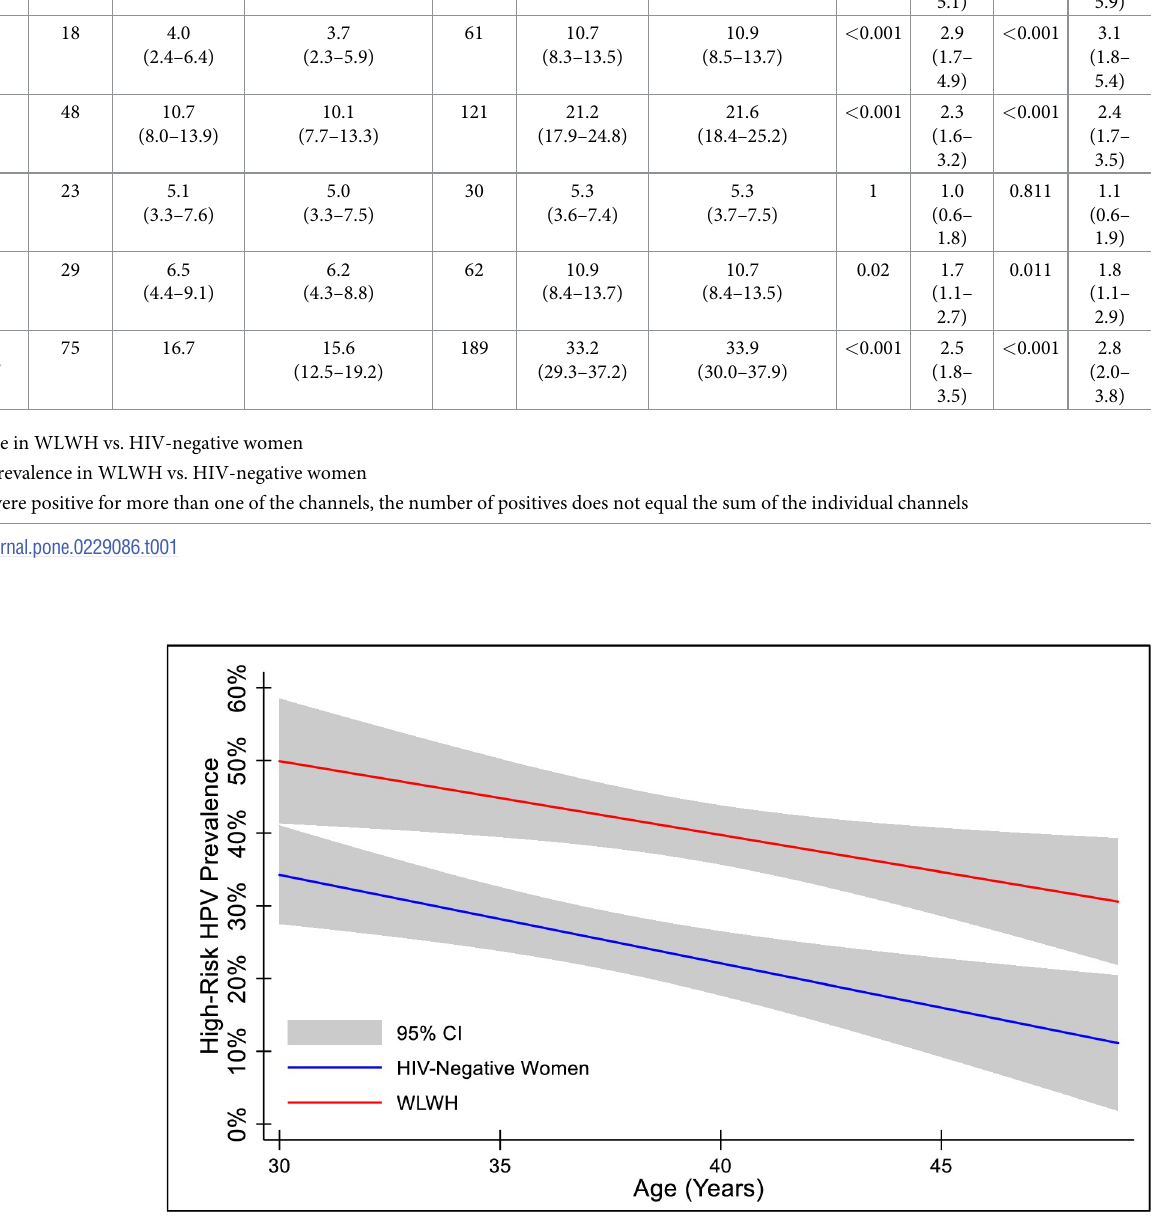
PLOS ONE | https://doi.org/10.1371/journal.pone.0229086 February 13,